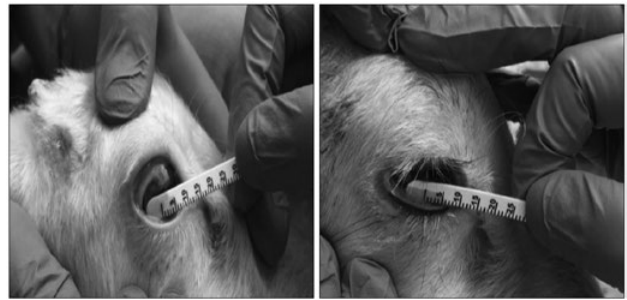
FIGURE 1 - Sampling with Schirmer tear test